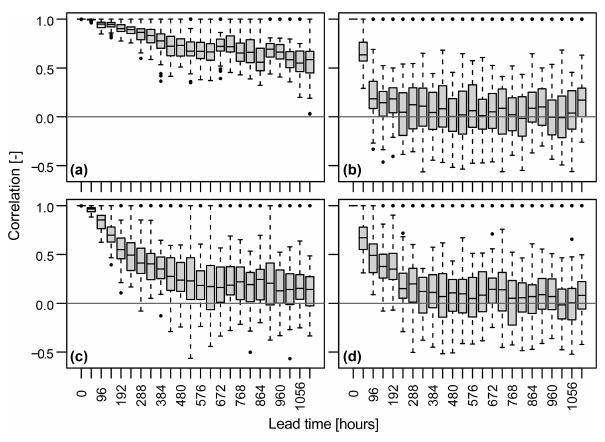
Figure 5. Member (in)dependence (Spearman’s correlation) per lead time – 0 to 110h (46d) – across the 10 perturbed ensemble members for four example stations with different flood seasonal- ity ratios (strong summer vs. strong winter flood regime; clockwise from upper left to lower right). (a) Kemijoki–Ounasjoki (strong summer flood regime). (b) Osterach–Reckenberg (summer flood regime). (c) Rhine–Maxau (winter flood regime). (d) Jouanne– Forcé (strong winter flood regime; Fig.